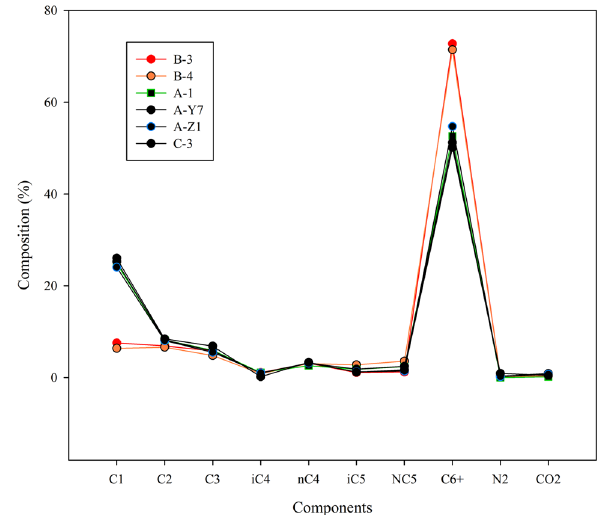
Compositions of initial fluids of the three fields at reservoir temperature and pressure. The compositions of the fluids in Fields A and C are identical, and the fluid in Field B contains heavier compo-